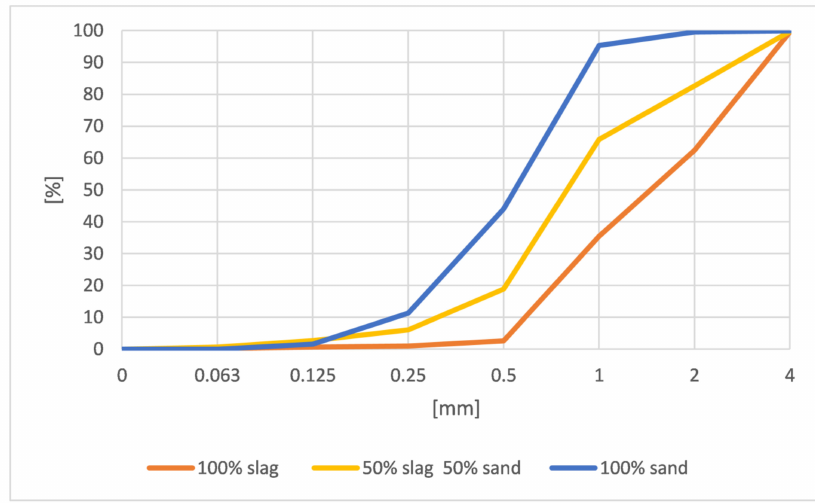
Figure 3. The grading curves of all types of aggregate